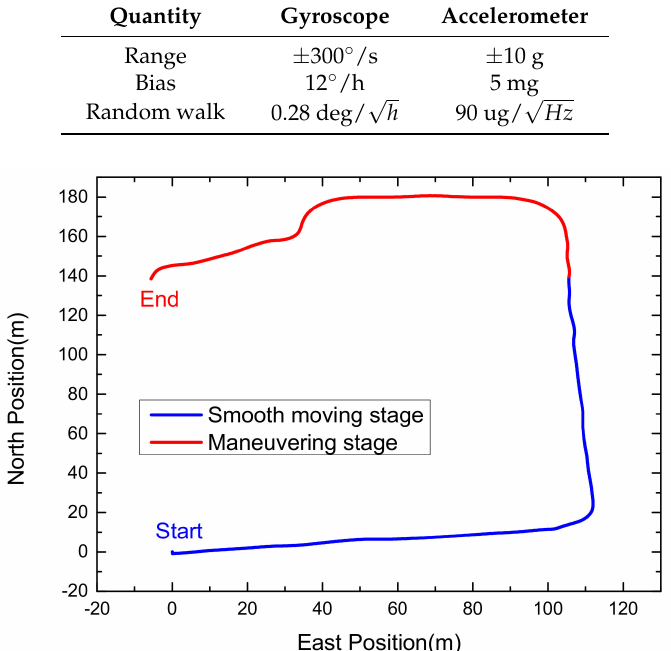
Figure 4. Car-mounted test trajectory.